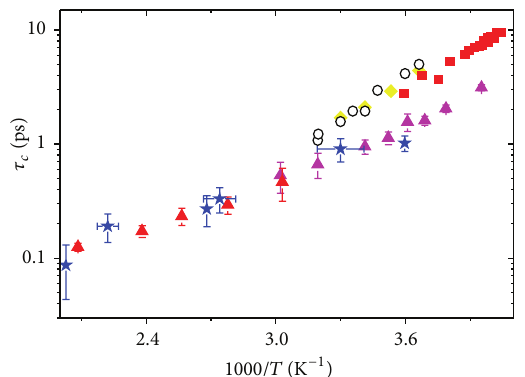
Figure 12: Arrhenius plot of the relaxation times of water measured by various spectroscopic techniques: (i) IXS [14] (from the analysis of the reduced longitudinal moduli discussed in the text, blue stars); (ii) BUVS [34] at 𝜌 = 1.015g/cm 3 (open circles); (iii) DLS from [35] (red triangles) and (iv) [36] (magenta triangles); (iv) BLS [7] (red squares); and (v) US [37] (yellow